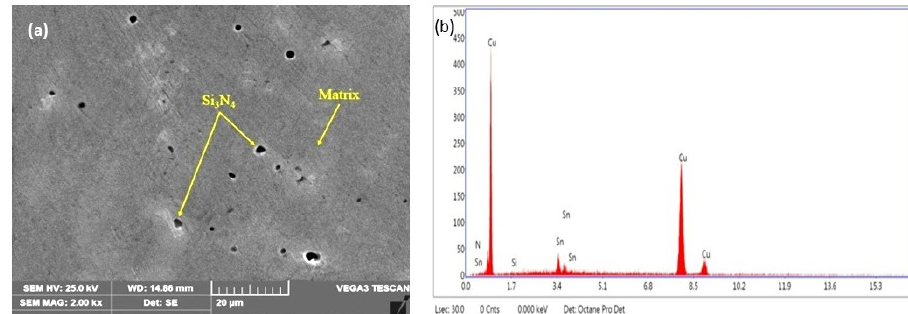
Figure 5: ASiN composite samples (a) SEM and (b) EDAX pattern.